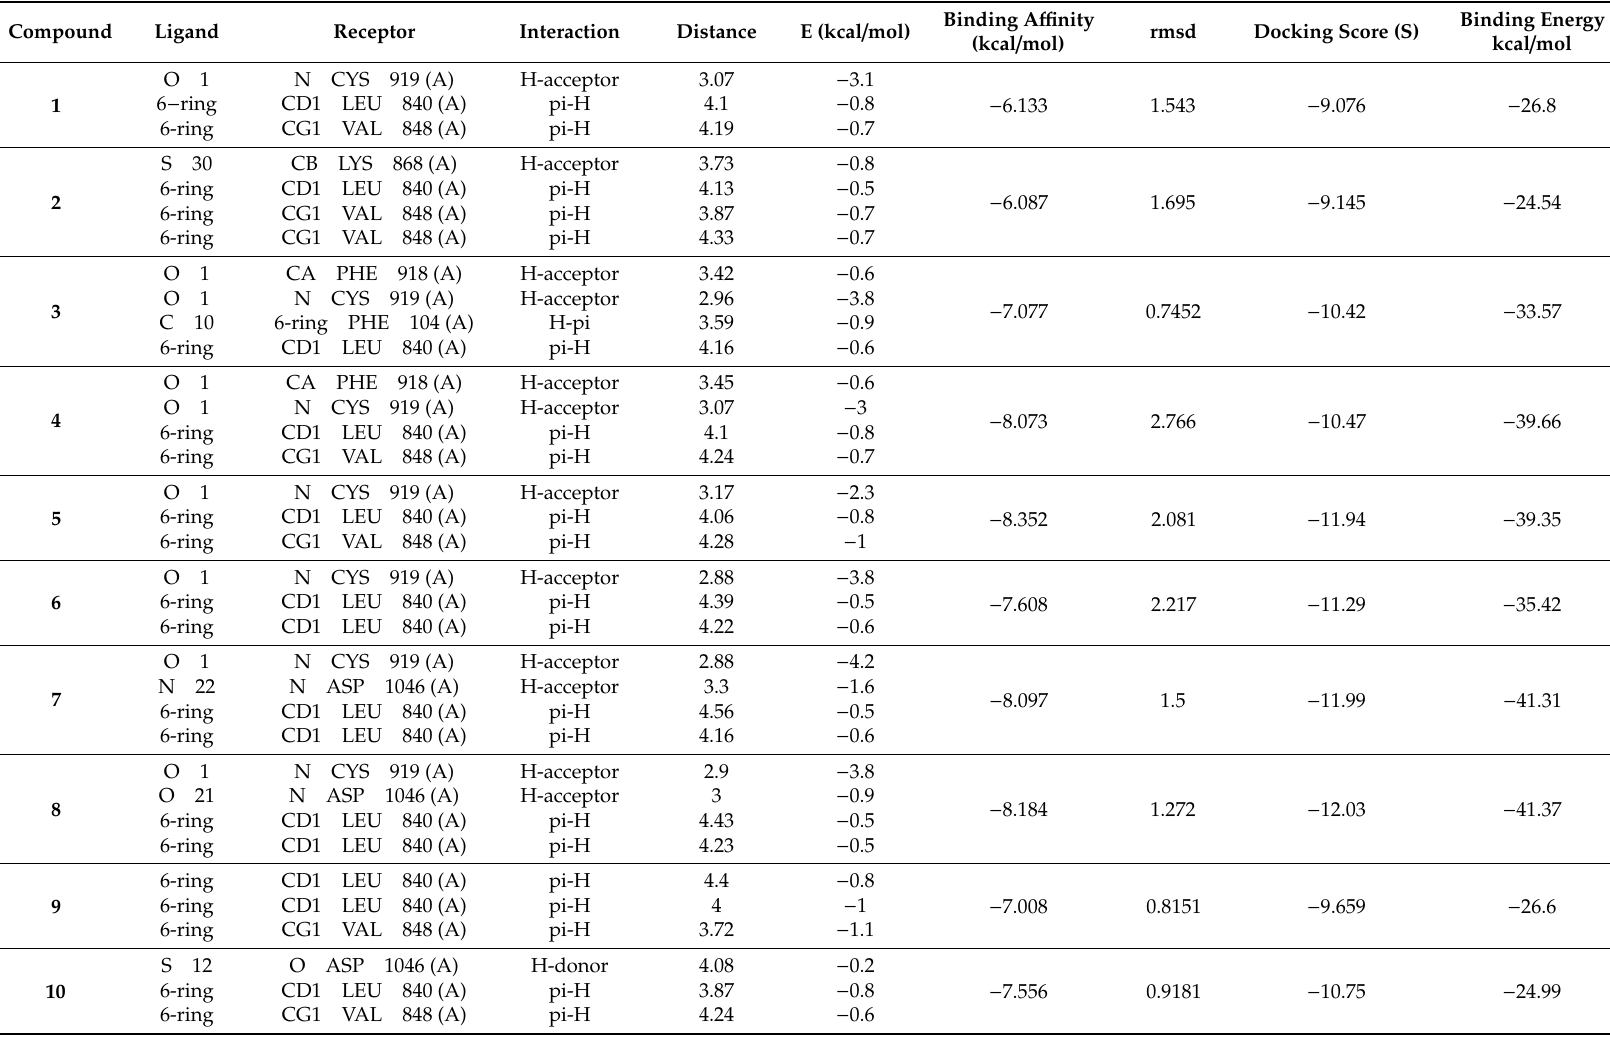
Table 4. Docking energy and interactions of compounds 1 – 17 and reference compounds with target protein